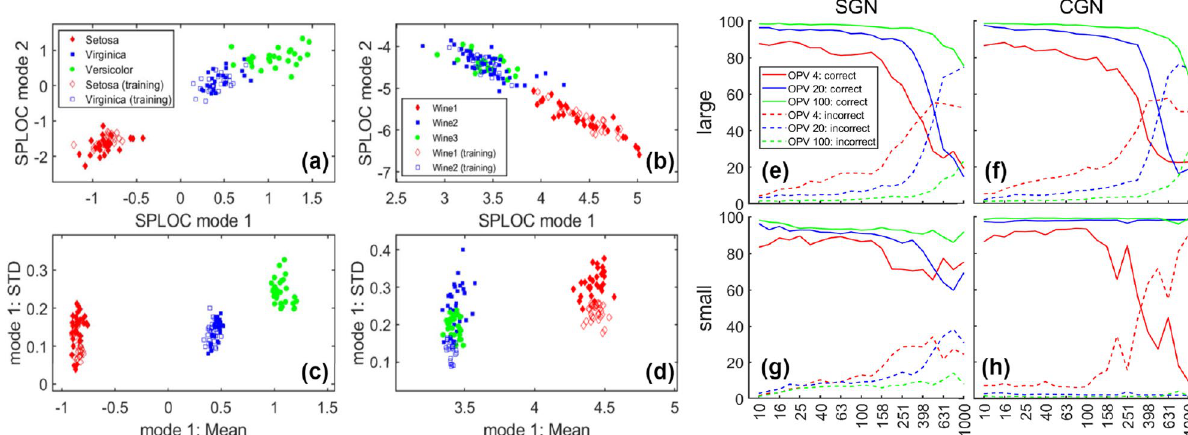
Figure 3. Classification and feature extraction benchmarks. The top two d-modes project the raw data into two dimensions for the (a) Iris and (b) wine datasets. The mean and STD of data packets are shown within a mode feature space plane for the top d-mode that describes the (c) Iris and (d) wine datasets. In the right panel, four tabulated graphs show egg reconstruction percentages in the discriminant (correct) and indifferent (incorrect) subspaces as a function of system size for 4, 20 and 100 observations per variable (OPV). System size is characterized by the number of df. (e–h) Four tabulated plots are shown for a (large, small) egg placed in (SGN, CGN). Egg reconstruction percentages are shown for discriminant (correct) and indifferent (incorrect) subspaces as a function of df at an OPV of 4, 20 and